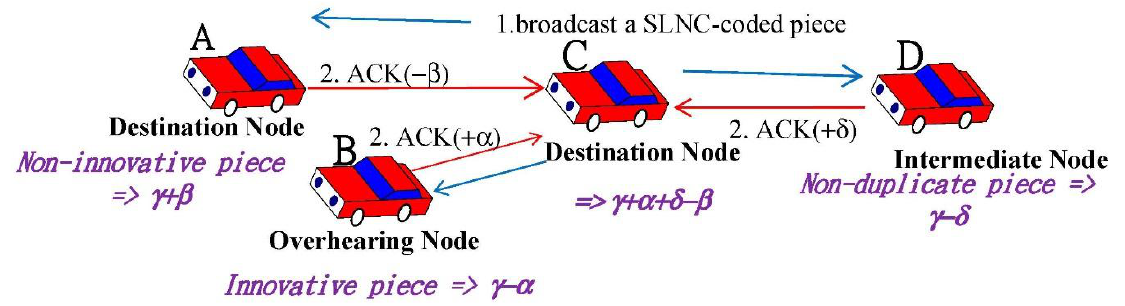
Figure 1. Credit values of node A, B, C and D after node C broadcasts a SLNC-coded content piece.